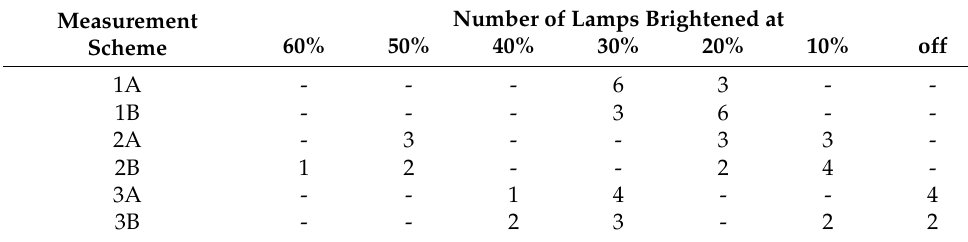
Table 4. The brightness levels of each lamp in each measurement